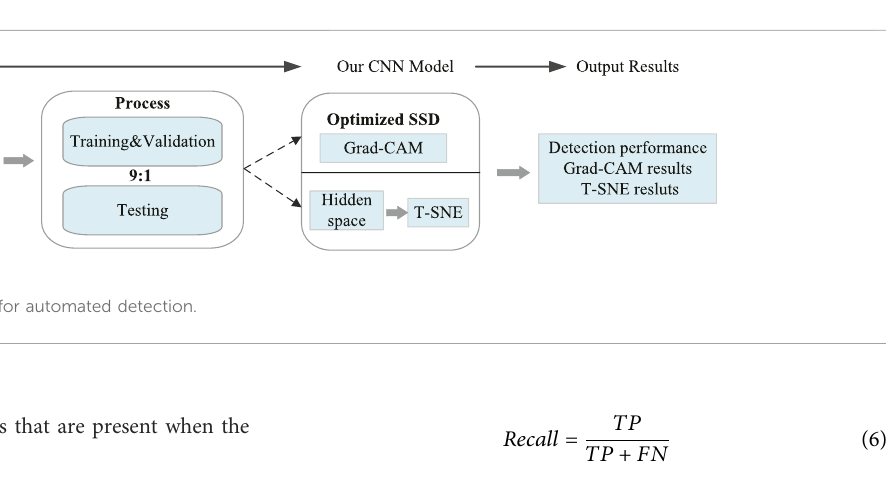
equal to the number of detection boxes that are present when the IOU is less than or equal to 0.5.